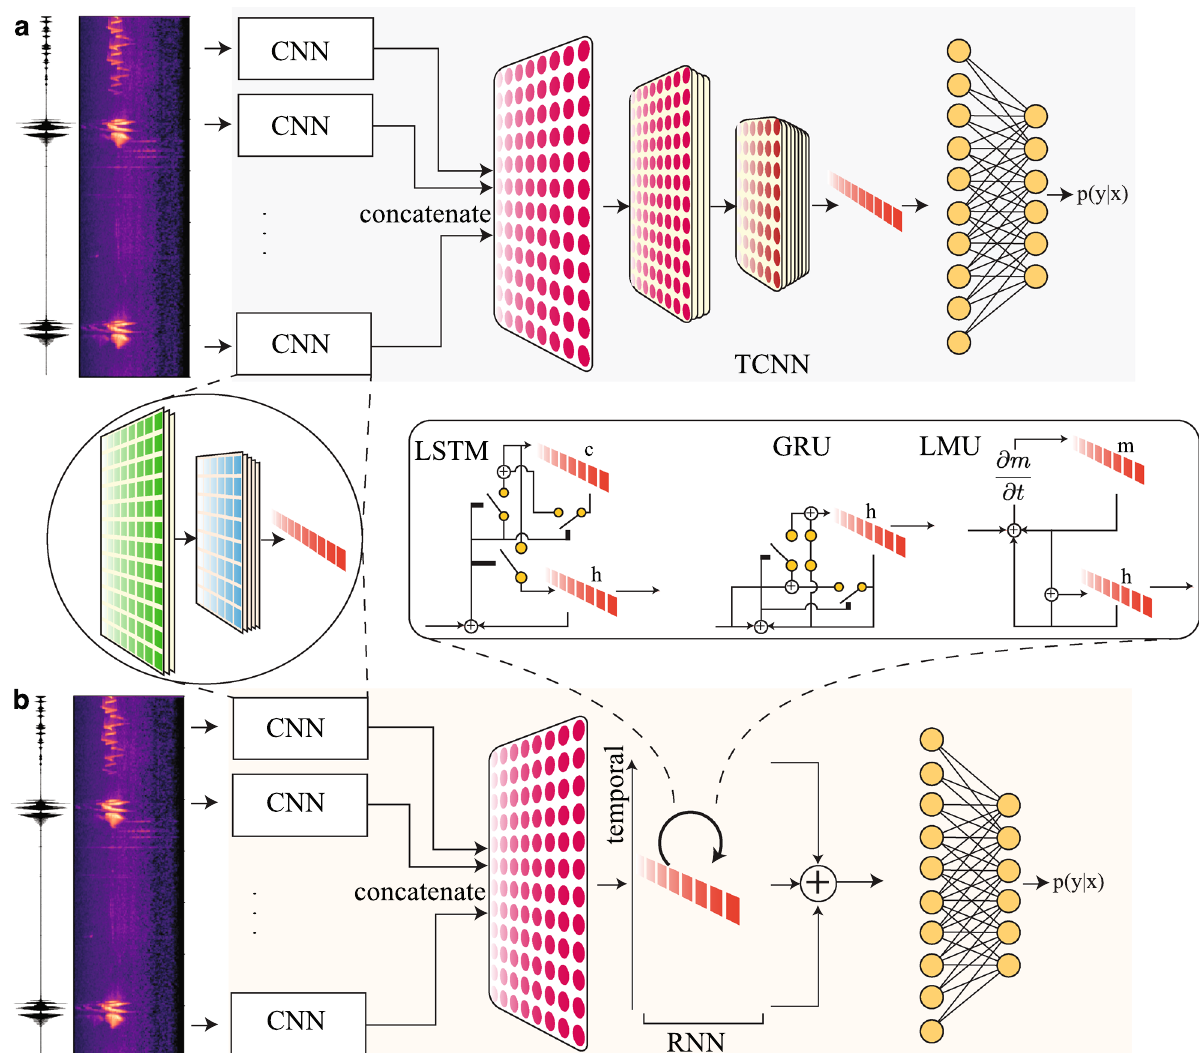
before feeding to the temporal layer in ( a , b